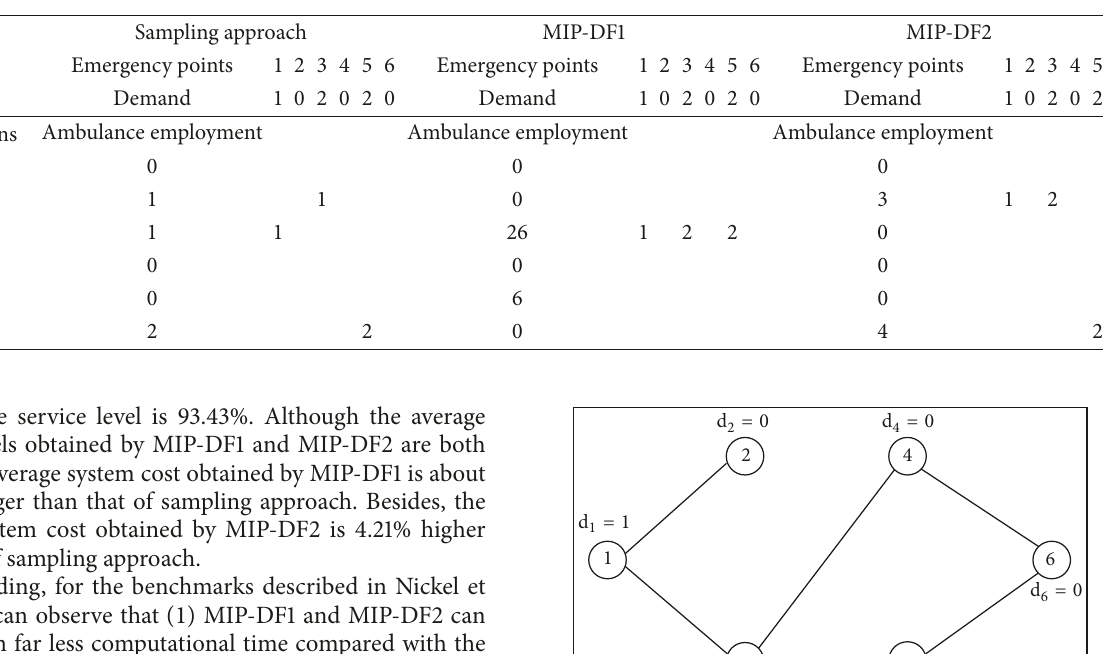
Table 3: Solutions to instance 4 in Nickel et al. [8] for the given scenario.